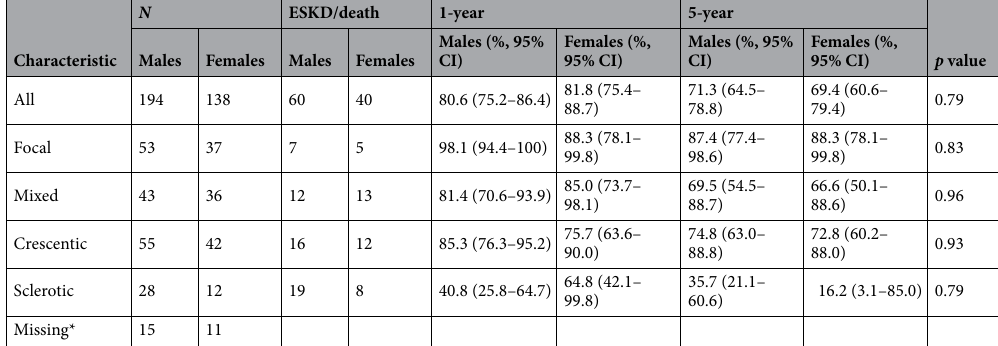
Table 3. Patient and renal survival at 1- and 5-years follow-up, stratified by gender and Berden classification. *Berden histological class missing in n = 26.